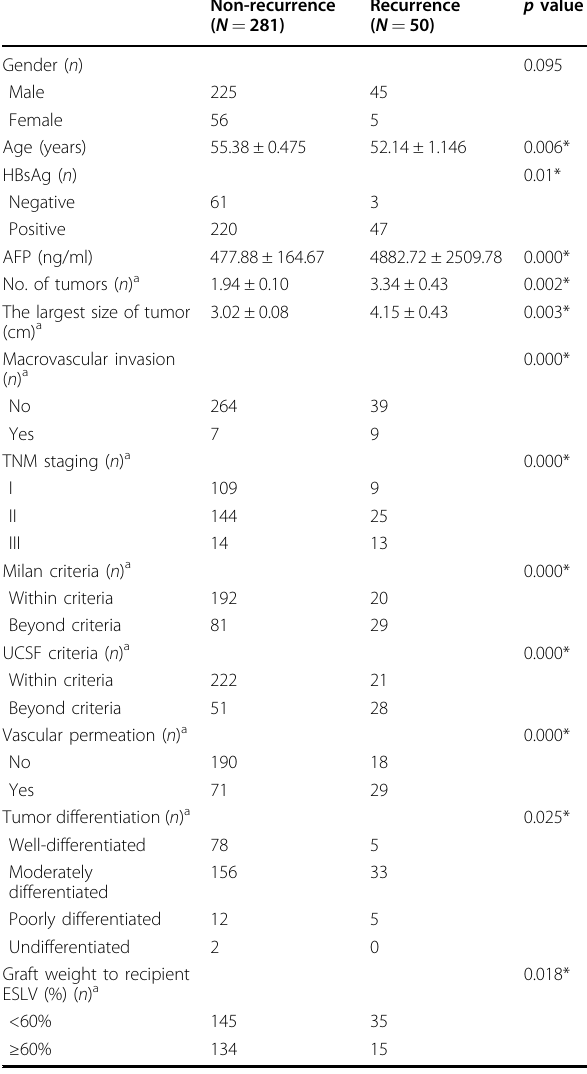
Table 1 Comparison of baseline characteristics between non-recurrent and recurrent HCC patients after liver